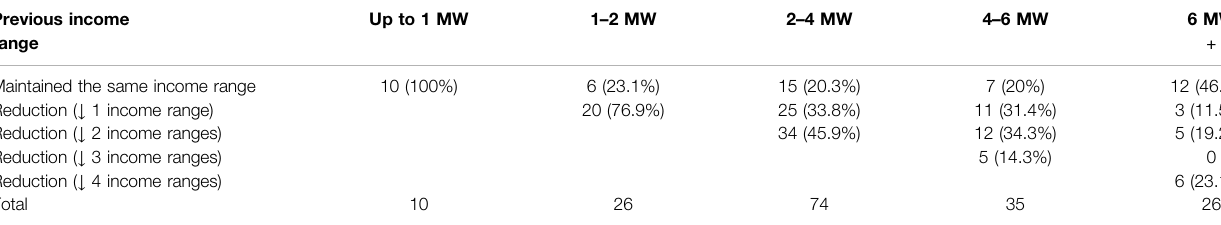
TABLE 1 | Effect caused by the pandemic on the monthly income of the respondents. Previous income